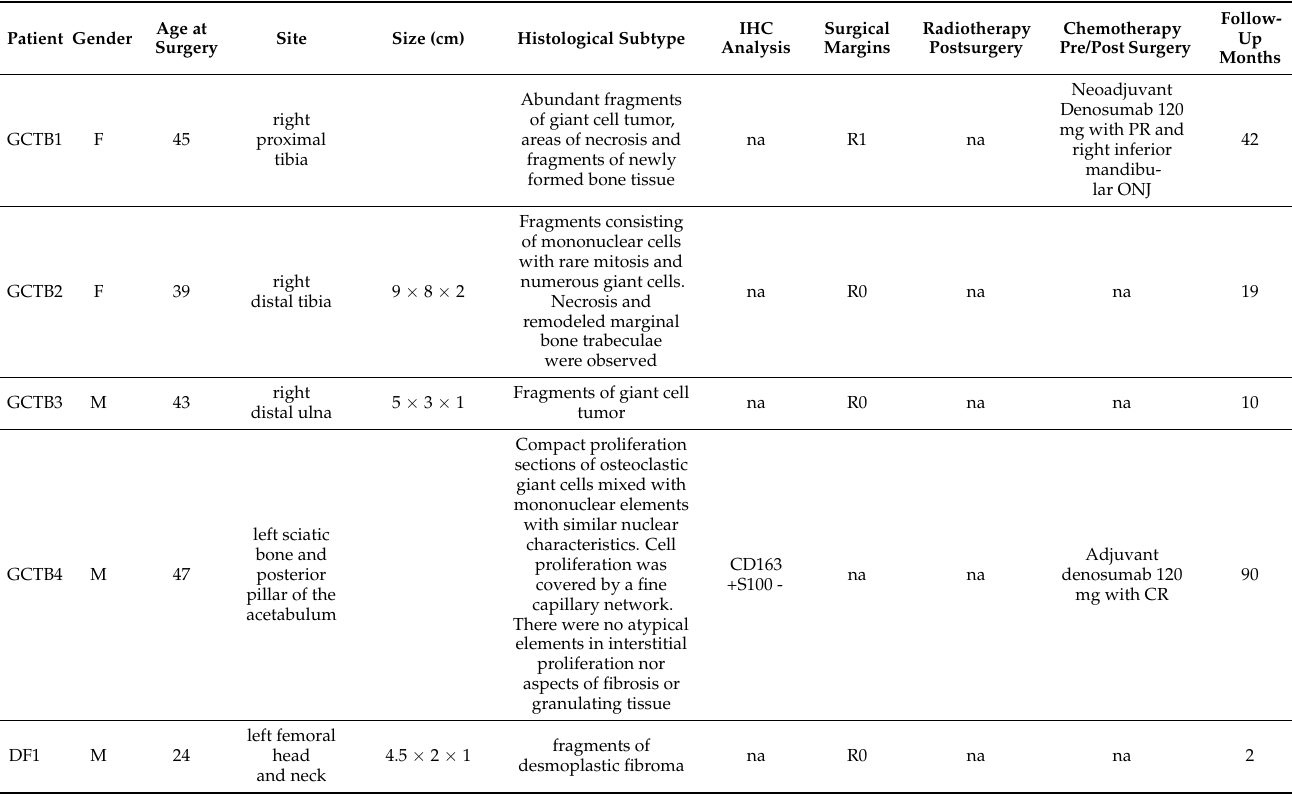
Table 1. Clinicopathological characteristics of GCTB and DF case